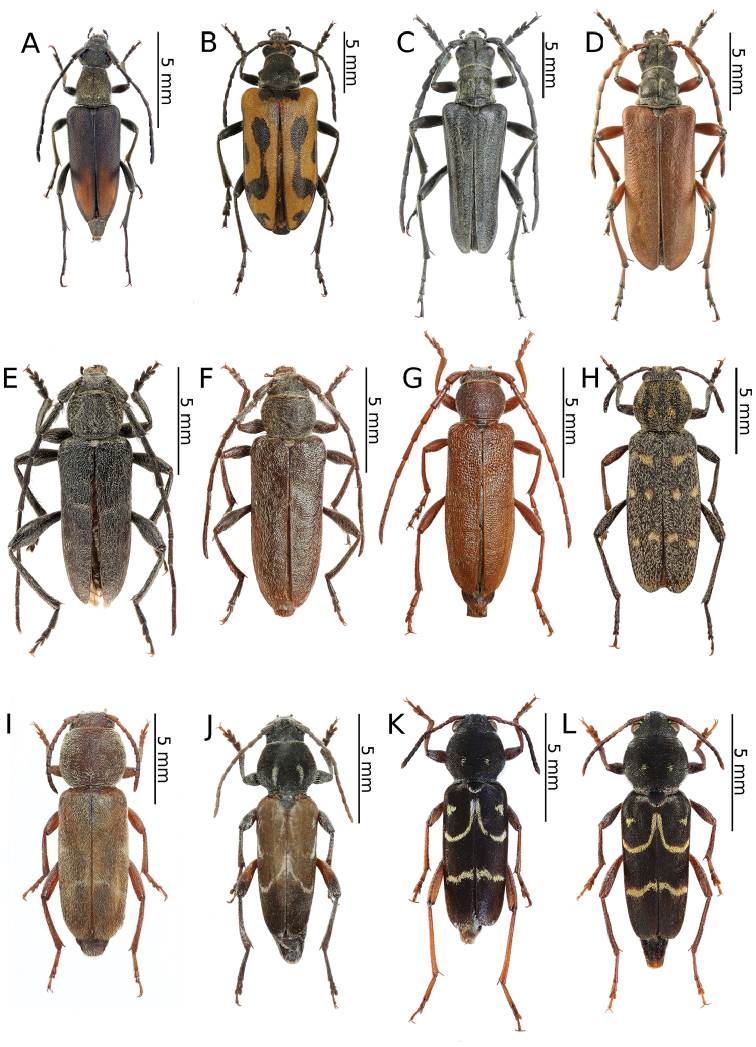
Photos of longhorn beetles specimens collected during the expedition to Kazakhstan in 2017: AAnastrangaliasequensi (female, melanistic form) BBrachytainterrogationisrussica (female) CStenocorusminutus (male) DS.minutus (female) ETuraniumscabrum (male, dark form) FT.scabrum (female, dark form) GT.scabrum (female, light form) HXylotrechusadspersus (male) IXylotrechusalakolensis (male) JXylotrechushircus (female) KXylotrechuscapricornus (male) LX.capricornus (female).